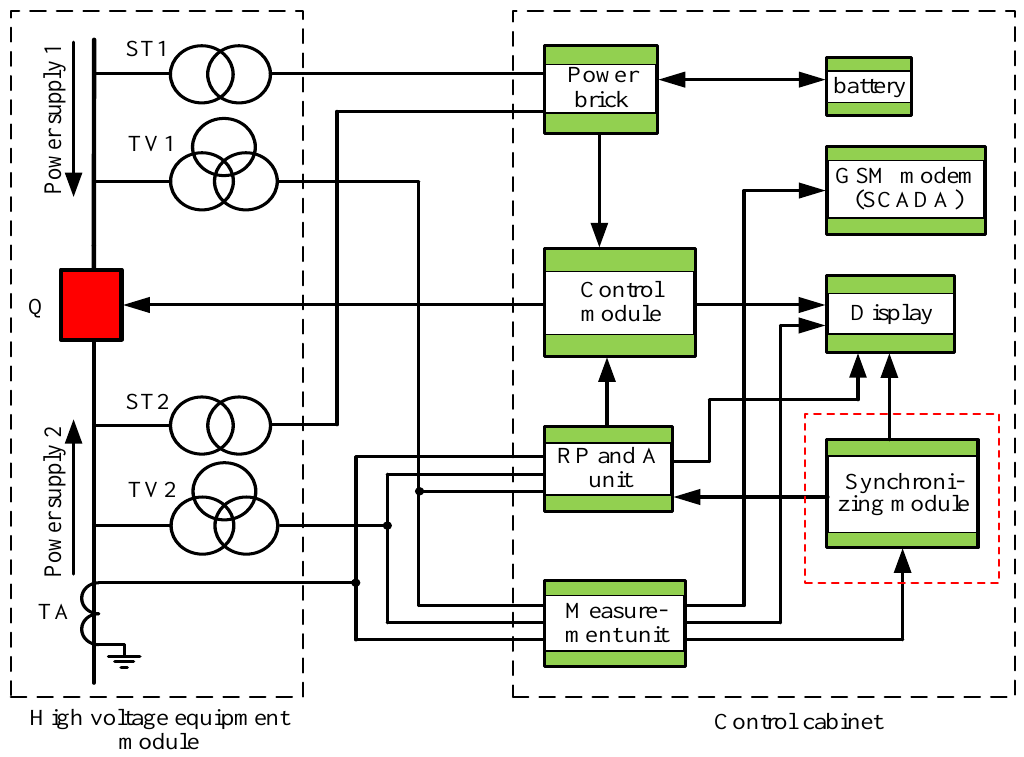
Figure 5. The functional control diagram of the modified recloser.